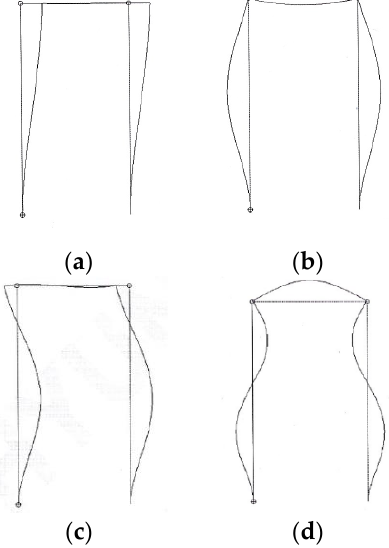
Figure 3. FEA Result of n-type structure: ( a ) 1st mode — asymmetry; ( b ) 2nd mode — symmetry; ( c ) 3rd mode — asymmetry; ( d ) 4th mode — symmetry.